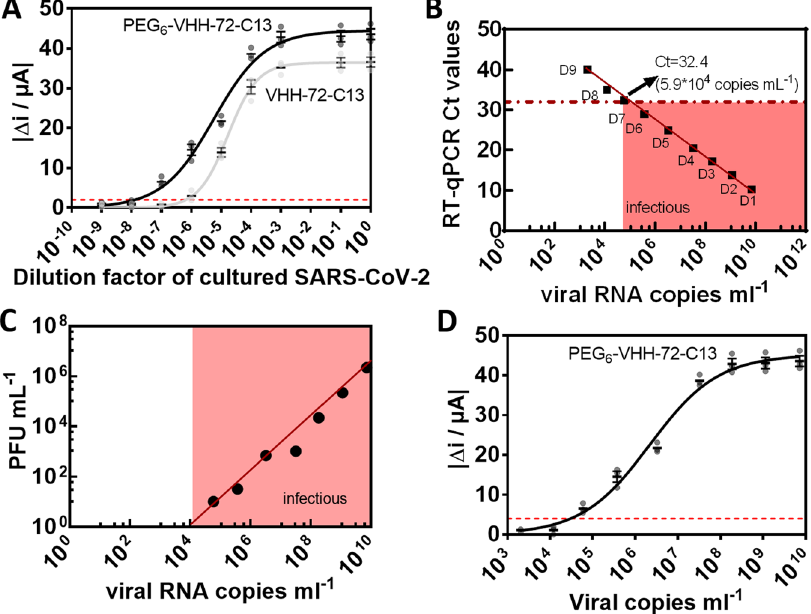
Fig. 5 Performance of Au-PEG 6 -VHH-72-C13 and Au-VHH-72-C13 electrodes on cultured SARS-CoV-2 EU variant. A Dose-dependent response curves of 10-fold dilutions (D1-D9) of SARS-CoV-2, clade 20 A.EU2 (EU variant) on VHH-72-13C modi fi ed electrodes and VHH-72 for comparison. B Correlation of qRT-PCR Ct values and viral RNA copies mL − 1 . C Correlation of viral RNA copies mL − 1 with plaque forming units of SARS-CoV-2 as a measure of infectivity. For this, Vero E6 cells were infected with 10-fold dilutions of a SARS-CoV-2 isolate clade 20 A.EU2 (EU variant). Calculation of estimated virus concentration was carried out by the Spearman and Karber method 20,21 and expressed as TCID 50 /mL (50% tissue culture infectious dose). TCID 50 /mL values were transformed to PFU mL − 1 by using the formula PFU mL − 1 = TCID 50 /mL × 0.7 (https://www.lgcstandards-atcc.org/support/faqs/48802/ Converting%20TCID50%20to%20plaque%20forming%20units%20PFU-124.aspx). RNA extraction and qRT-PCR (target IP4) were performed in duplicate for each dilution. D Dose-dependent response curves of viral copies of SARS-CoV-2, clade 20 A.EU2 (EU variant) on VHH-72-13C modi fi ed electrodes. The results are expressed as the mean ± SEM of at least 3 independent electrodes for each group. COMMUNICATIONS MEDICINE| (2022) 2:56